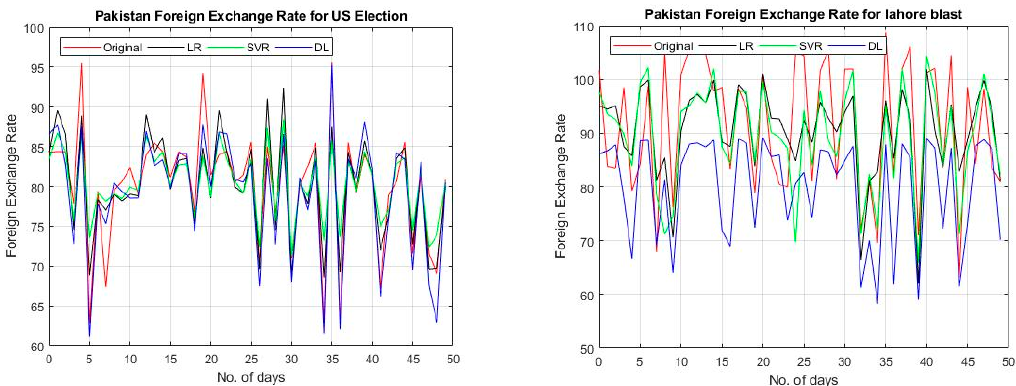
Figure 5. The plot of 50 forecasted and actual values of the foreign exchange rate of Pakistan considering linear, support vector, and deep learning model with the sentiment of US election and Lahore blast. LR: Linear regression, SVR: Support vector regression, DL: Deep